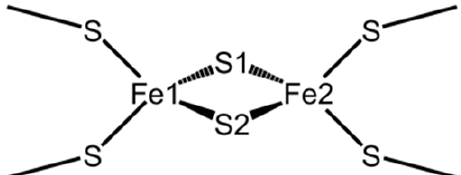
Figure 1. Chemical structure of the [2Fe‒2S] cluster.